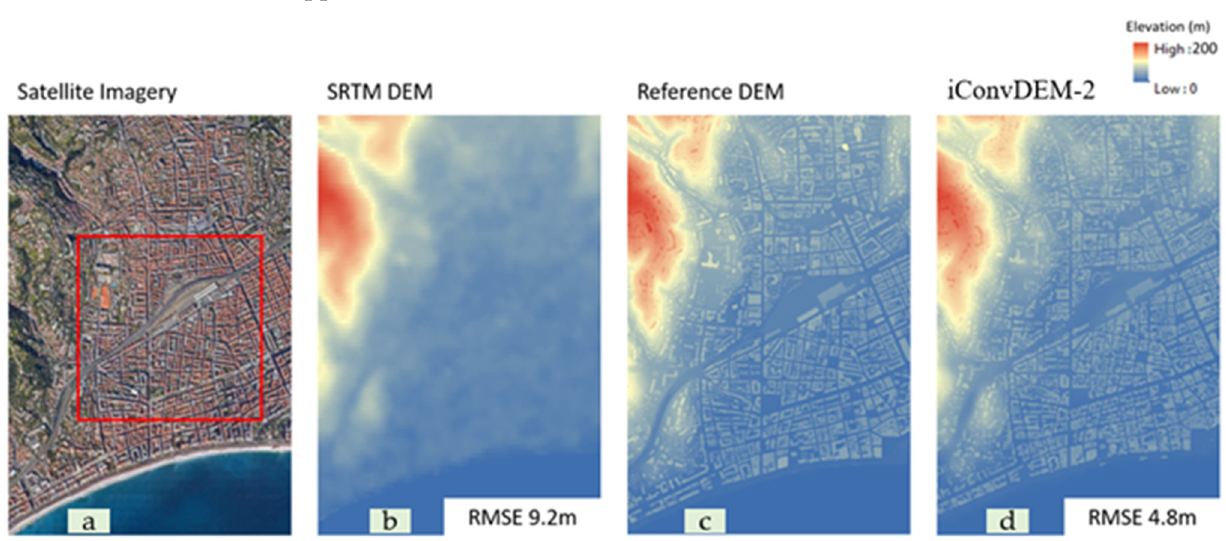
Figure A1. Plots at the validation site in Nice of: ( a ) satellite image, ( b ) SRTM DEM, ( c ) reference DEM and ( d ) iConvDEM-2.